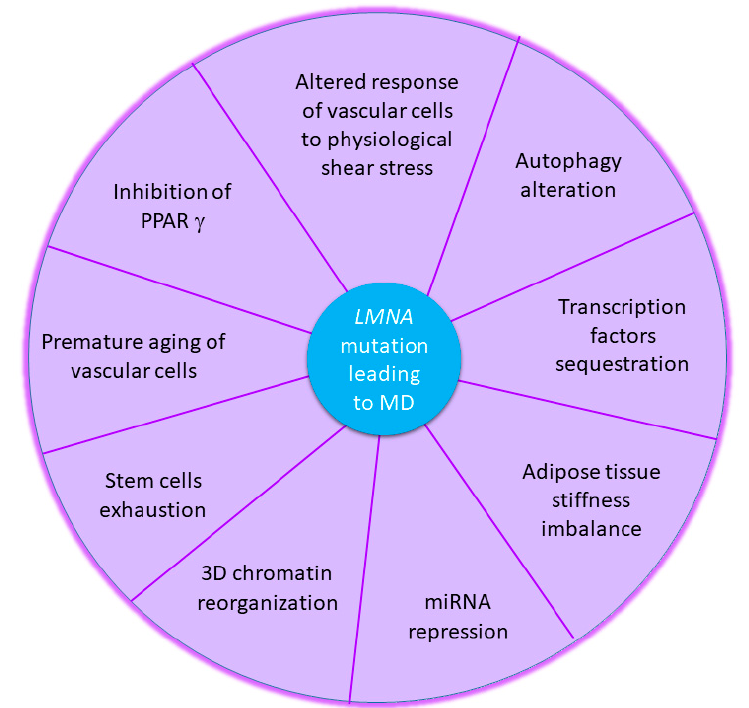
Figure 3. Cellular and molecular hallmarks of metabolic disorders associated with LMNA mutations.